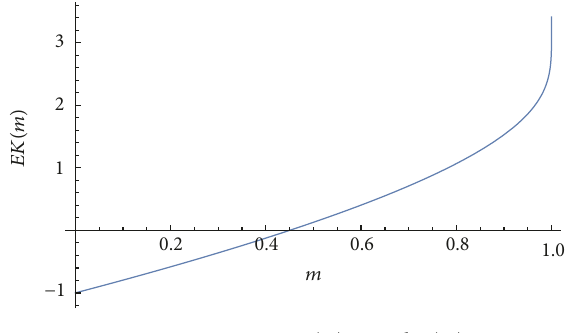
Figure 1: Function 𝐸𝐾(𝑚) given by (16).